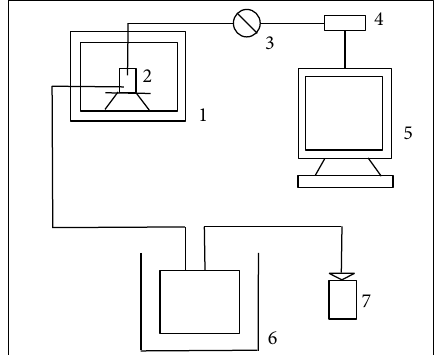
Figure 3: Schematic diagram of microwave pyrolysis. (1) Microwave generator. (2) Quartz glass. (3) Thermocouple. (4) Data acquisition instrument. (5) Computer. (6) Condenser. (7) Gas